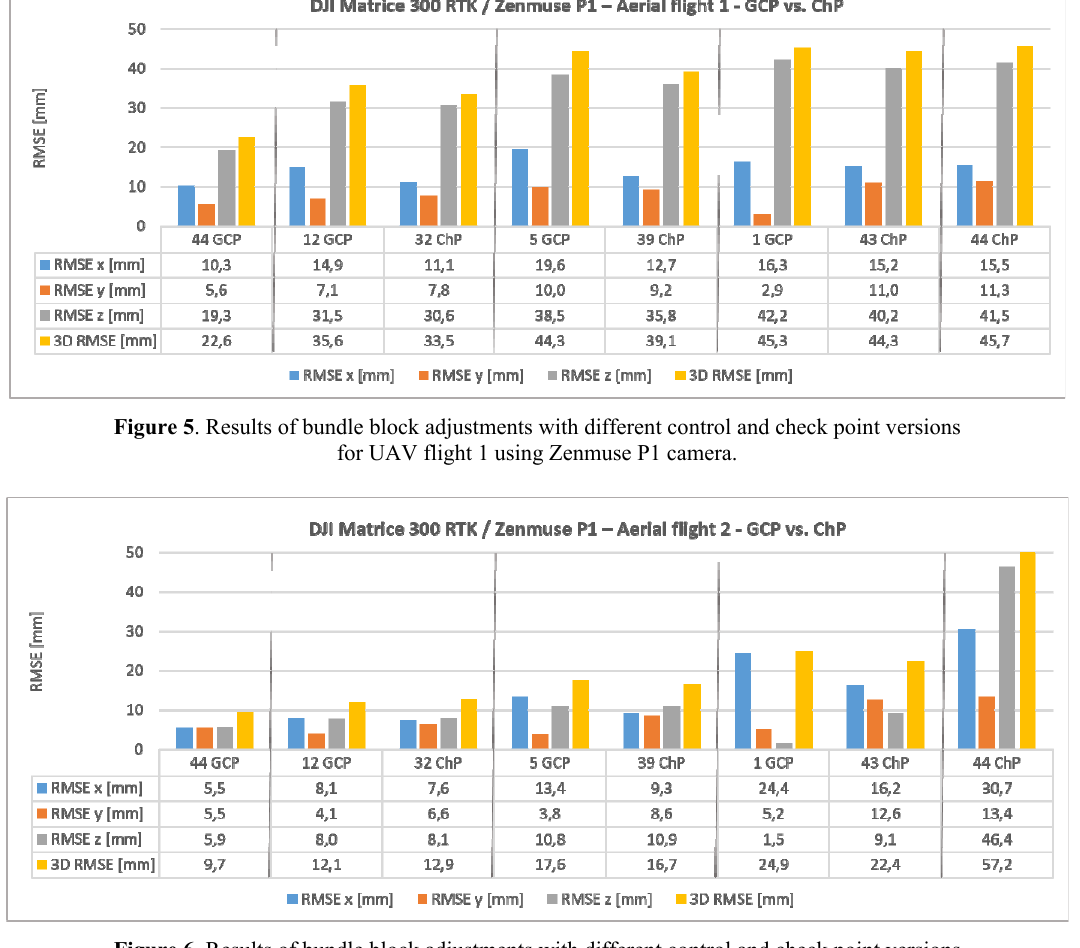
Figure 6 . Results of bundle block adjustments with different control and check point versions for UAV flight 2 using Zenmuse P1